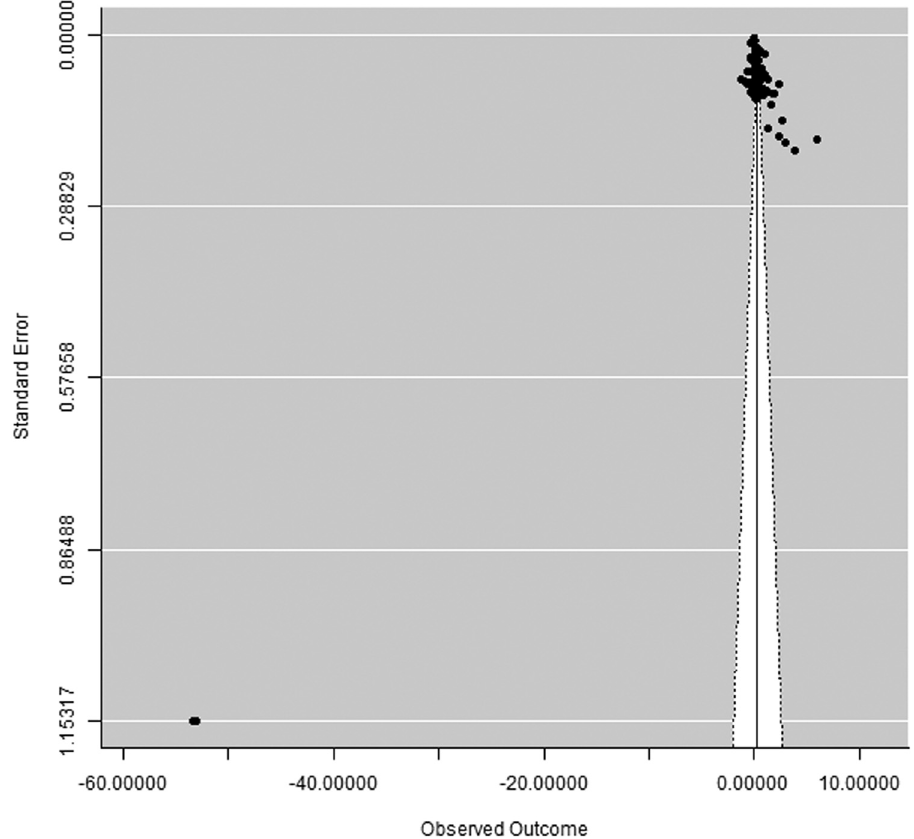
Figure 4: Funnel plots of the impact of cassava intervention on FCE in broiler